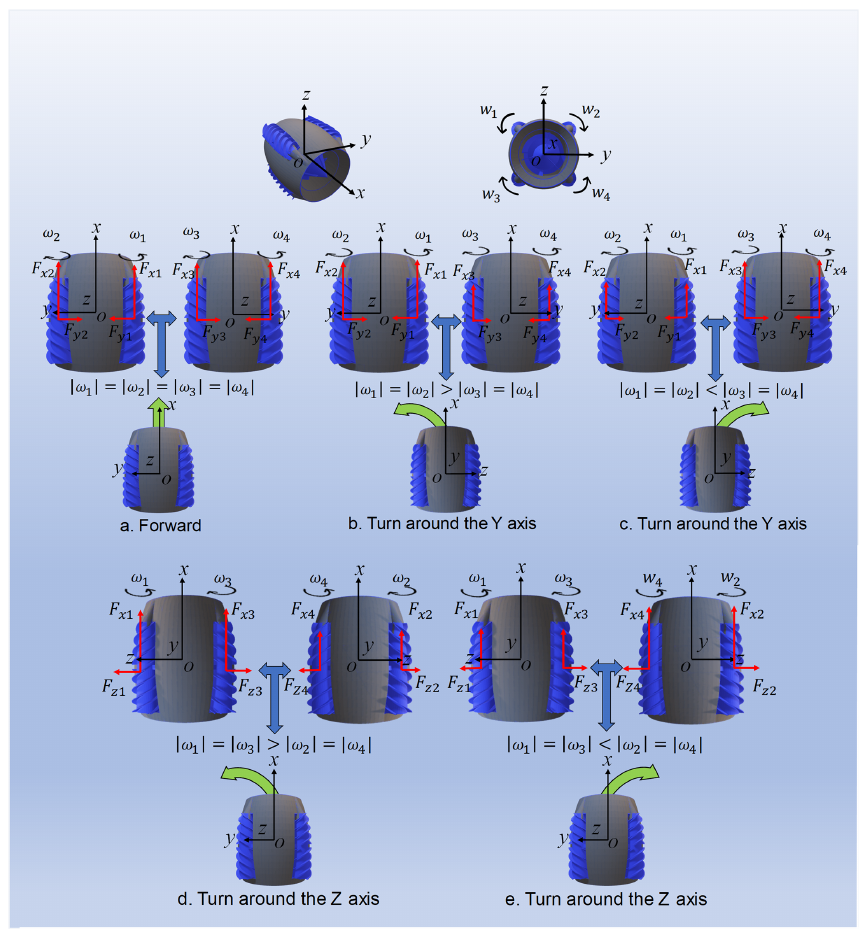
Figure 5. Relationship between screw speed and driving direction of the mechanism. Note: ω 1 is the rotational speed of the right-hand screw, ω 2 is the rotational speed of the left-hand screw, ω 3 is the rotational speed of left-hand screw, and ω 4 is the rotational speed of right-handed screw. The rotational speed of the screw is the same as the direction of the screw. F x is the axial force on the screw, and F y and F z are the lateral forces on the screw.